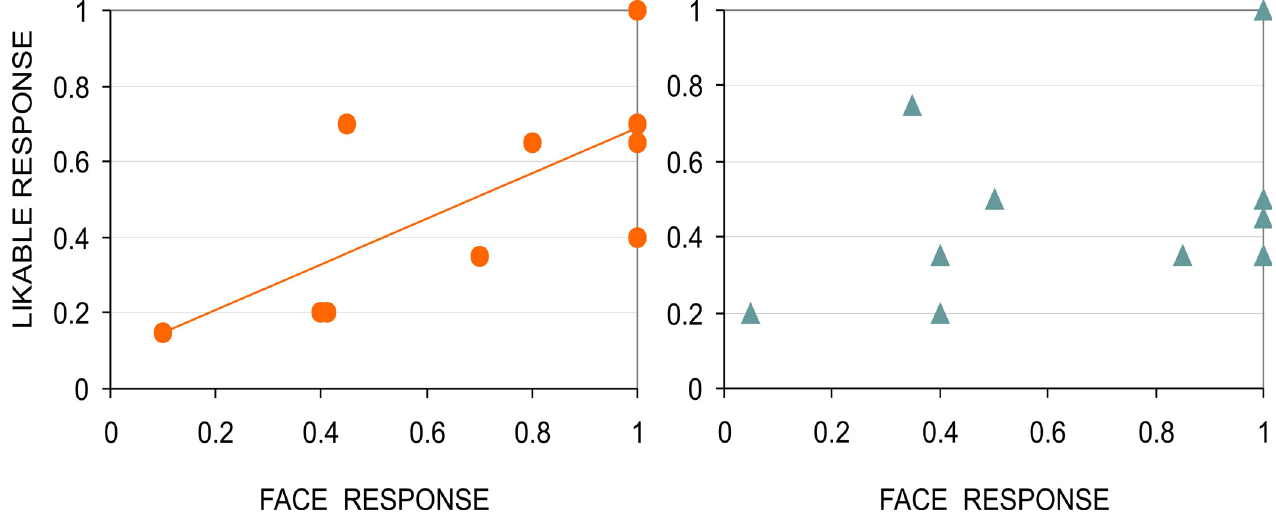
Fig 5. Face resemblance and face likability. Relationship between likability (as proportion of likable-face responses) and face resemblance (as proportion of face responses) for female, left panel, and male, right panel, participants; trendlines are shown for illustrative purposes only.